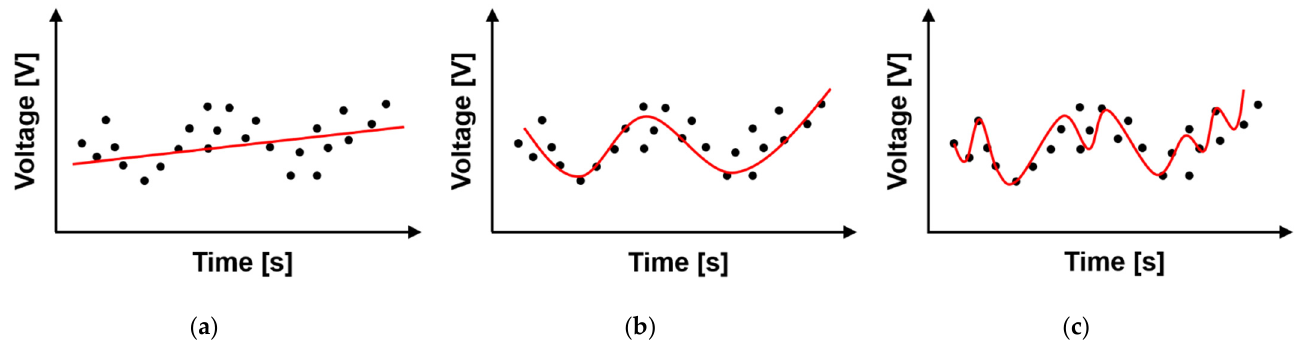
Figure 3. Trend lines of the DC drift in the proposed detrending technique depending on the polynomial order: ( a ) under fitting; ( b ) best fitting; ( c ) over fitting.